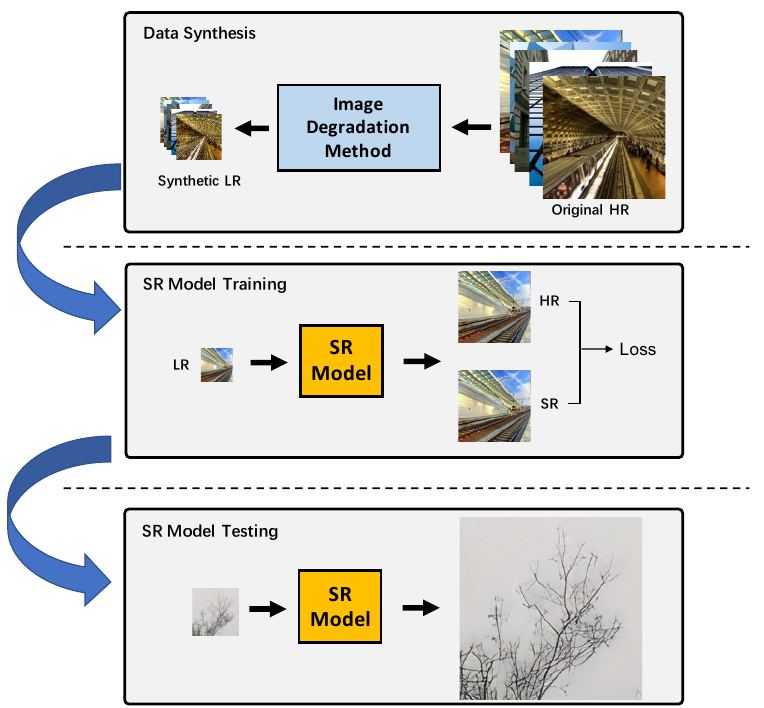
Figure 4. The scheme of SR model training and testing with different image degradation model- ing